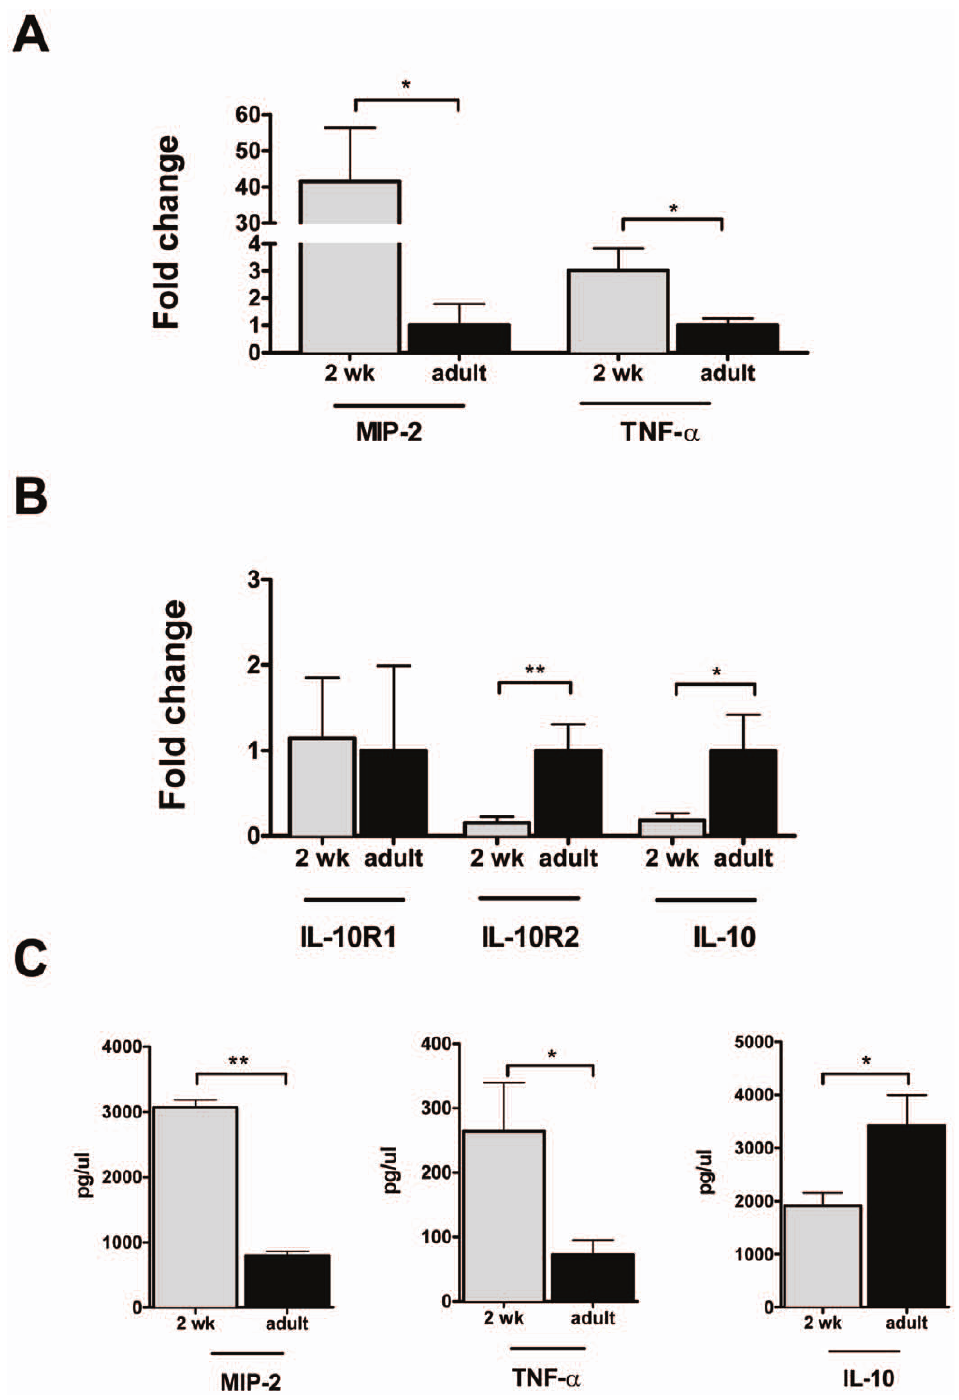
Figure 2. 2 week-old mice have higher colonic levels of proinflammatory and lower levels of anti-inflammatory mediators than adults. Mice were raised under conventional conditions and sacrificed at 2 weeks or as adults (6–8 weeks of life) and the colon excised and processed for analysis of mRNA (A) of the proinflammatory cytokines MIP-2 and TNF- a . mRNA expression data is depicted as mean fold change 6 SEM, relative to adult mice. B. Colonic mRNA expression of IL-10 and its receptor subunits is depicted for 2 week-old mice, relative to adult controls. C. MIP-2, TNF- a and IL-10 cytokine levels of colonic supernatants determined by ELISA are depicted as mean concentration 6 SEM. (*p , 0.05, **p , 0.01, n=5 2 7 per age group). doi:10.1371/journal.pone.0051955.g002 mice were sacrificed and colonic explants were prepared. Super- IL-10 receptor prevented LGG -mediated decreases in the expres- natants were collected and assessed by ELISA for MIP-2 sion of MIP-2 (Figure 5A) and TNF- a (Figure 5B). Taken together, (Figure 5A) and TNF- a (Figure 5B). Antibody-blockade of the these findings indicate that LGG -mediated reduction in inflamma-